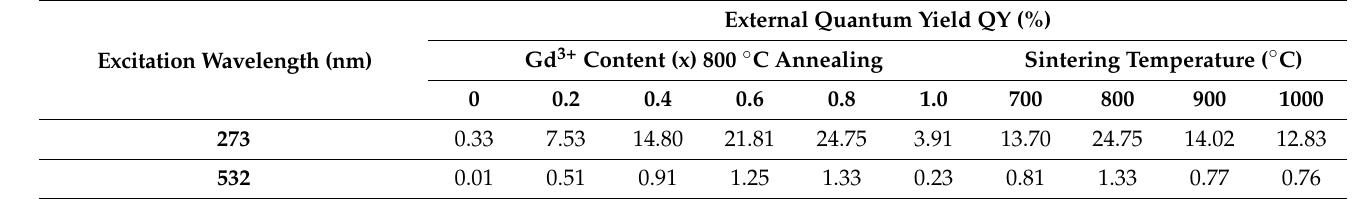
Table 1. Quantum yields in Gd 3+ -Bi 3+ co-doped phosphors with different Gd 3+ contents and sintering temperatures under 273 and 532 nm